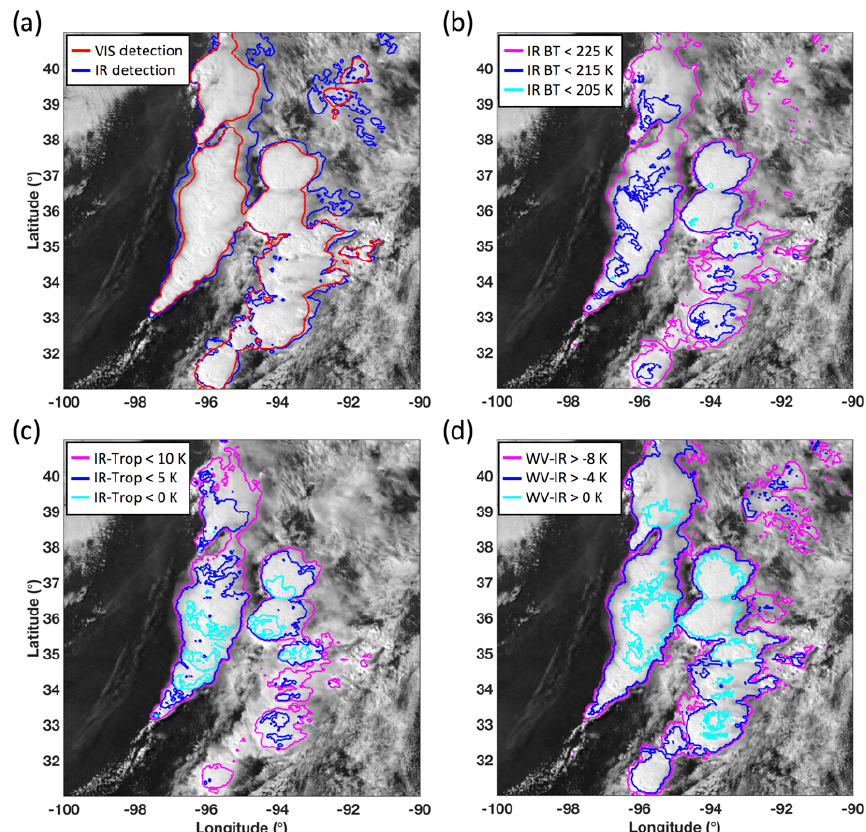
Figure 11. A cluster of developing thunderstorms near Kansas and Missouri on 13 April 2018 viewed from GOES-16 at 20:45UTC overlaid with (a) the VIS and IR anvil masks; (b) contours for IR BT less than 225, 215, and 205K; (c) contours for IR − Trop BTD less than 10, 5 and 0K; and (d) contours for WV − IR BTD greater than − 8, − 4, and